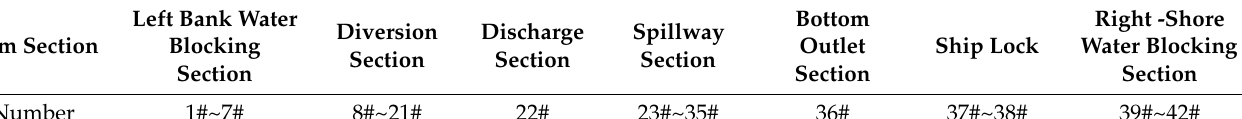
Table 2. The distribution of each dam section.